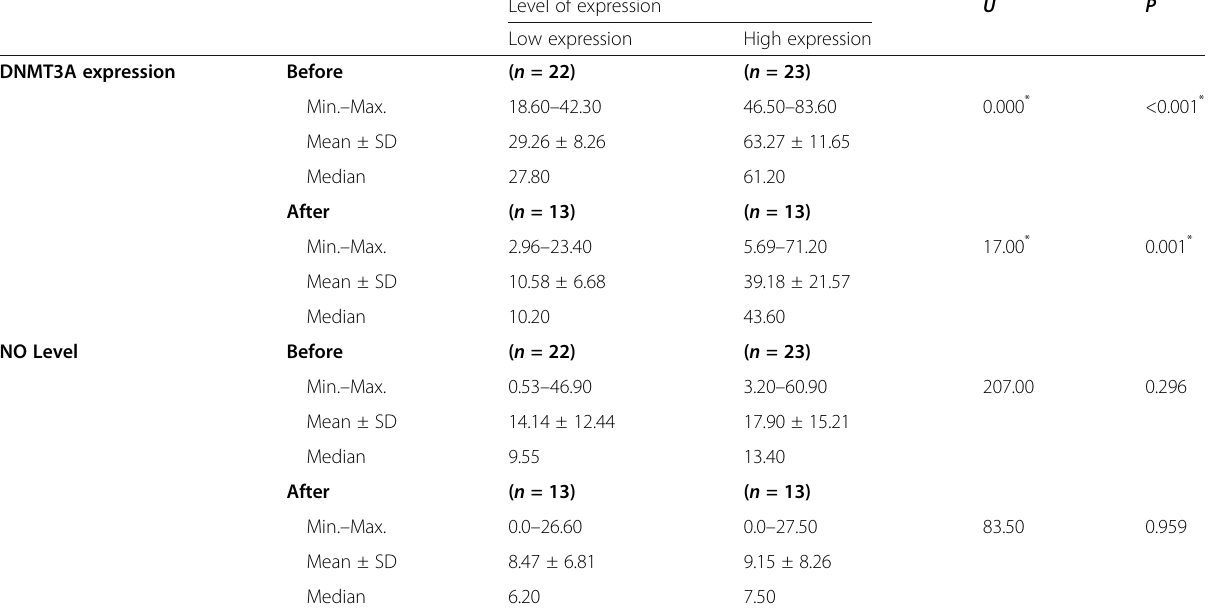
Table 5 Comparison between levels of DNMT3A gene expression and NO level before and after treatment Level of expression U P Low expression High expression DNMT3A expression